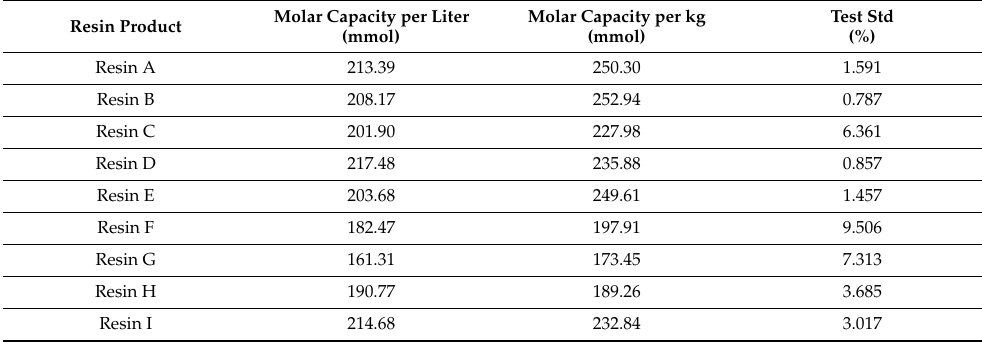
Table 1. Comparison of calculated averaged molar capacities of resin products and test result standard deviation per sample in %.